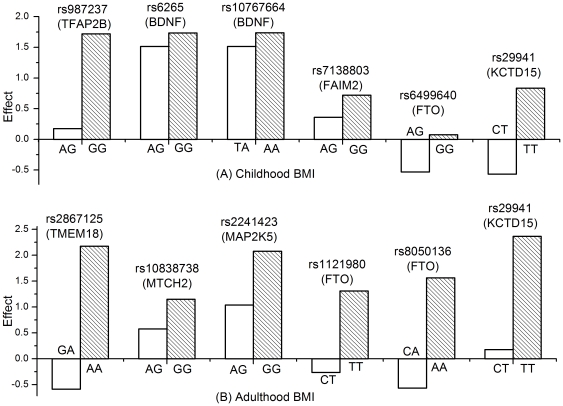
Major effects of genotypes for candidate SNPs on repeated measures of (A) childhood BMI and (B) adulthood BMI, adjusted for age and birth weight.